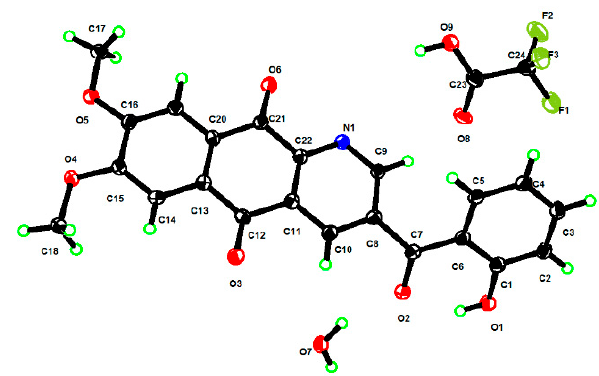
Figure 3. The single crystal structure of 3t .